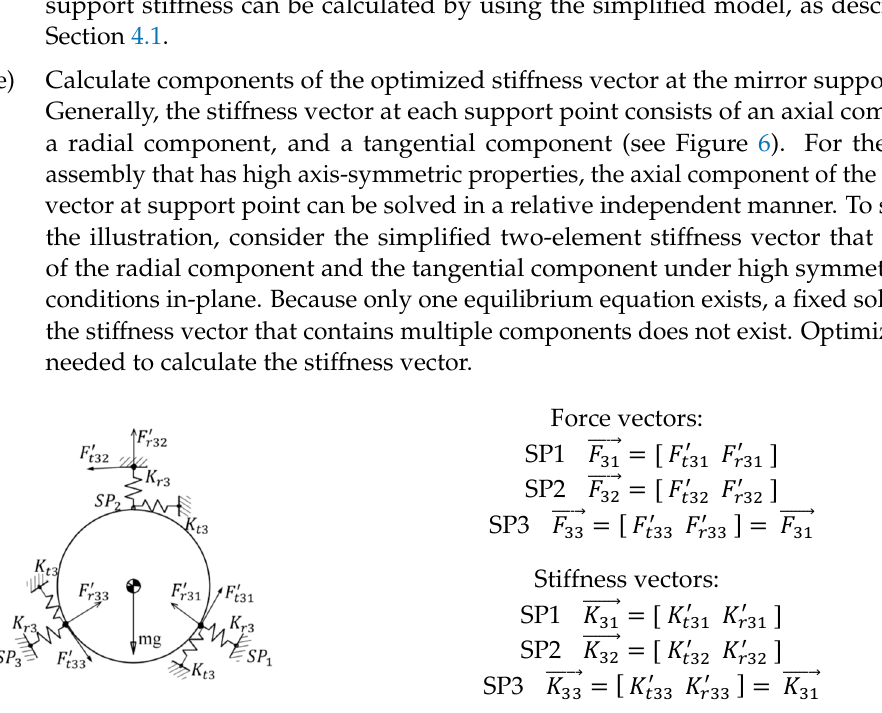
Figure 6. Illustration of the support vectors for the exemplified three-point support scheme.